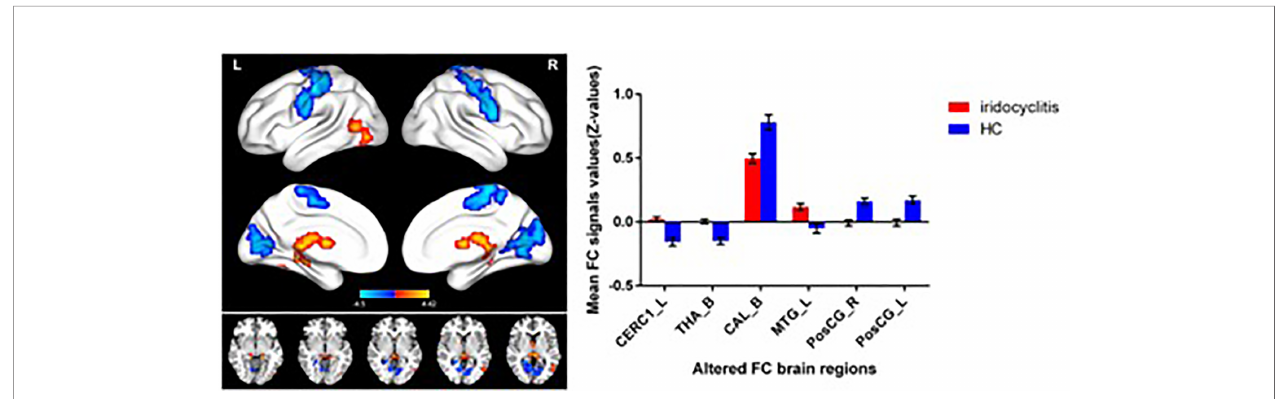
FIGURE 4 | Brain areas with statistically signi fi cant differences between two groups in FC of the right V1. Signi fi cantly FC differences were shown between the right V1 and CERC1_L, THA_B, MTG_L, CAL_B, PosCG_L and PosCG_R (voxel-level P <0.01, GRF correction, cluster-level P <0.05). FC, functional connectivity;